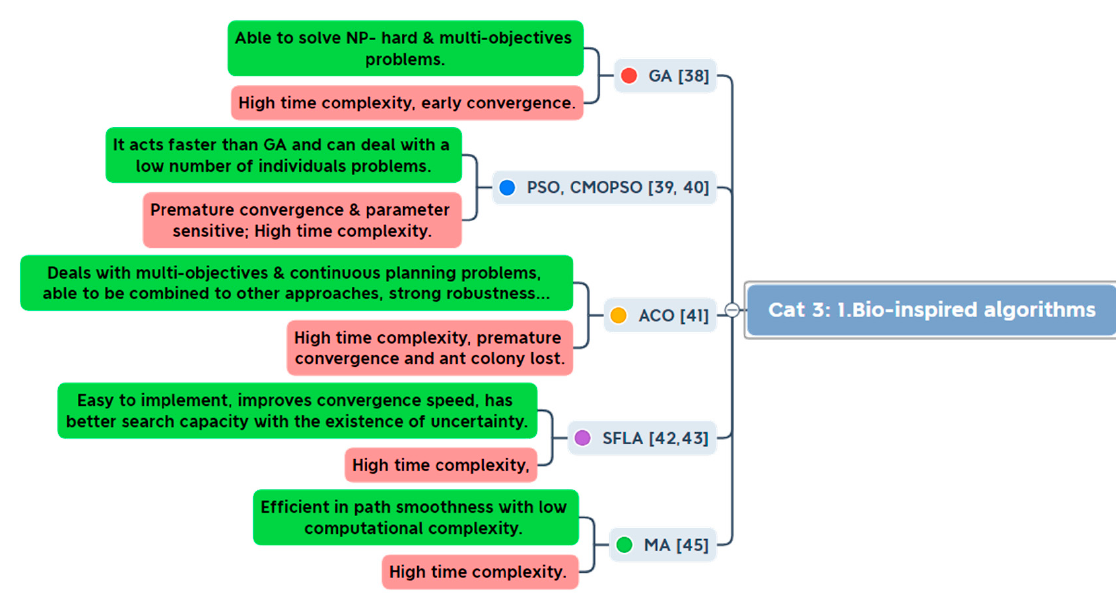
Figure 6. Evolutionary algorithms with the main advantages and drawbacks.